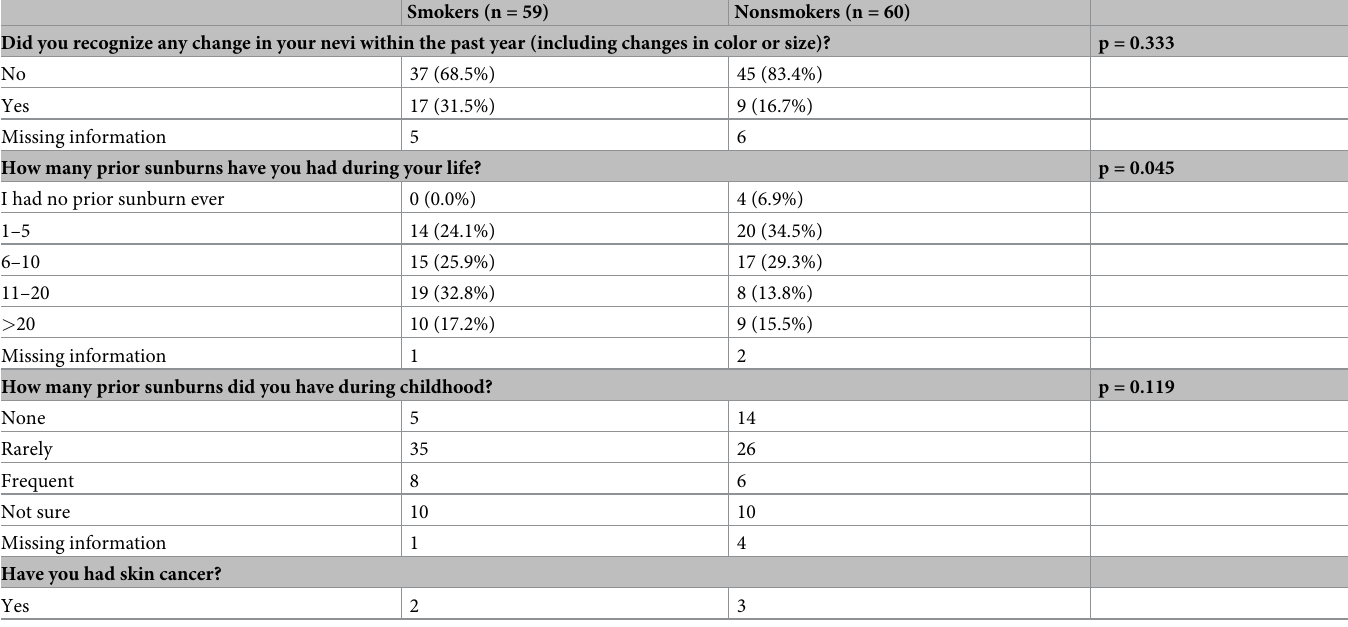
Table 4. Participants’ history.